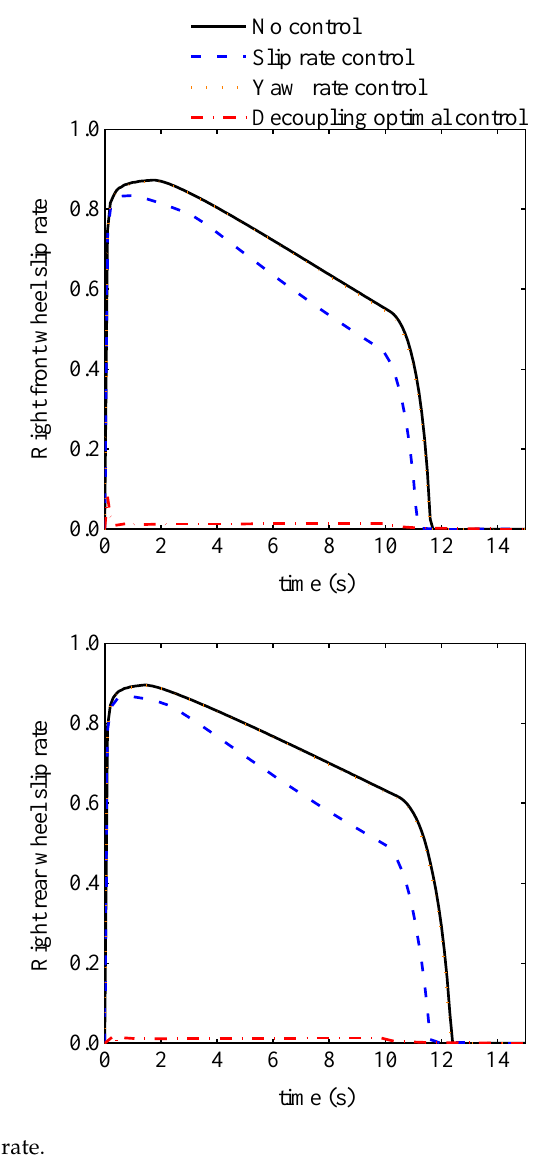
Figure 19. Slip rate.